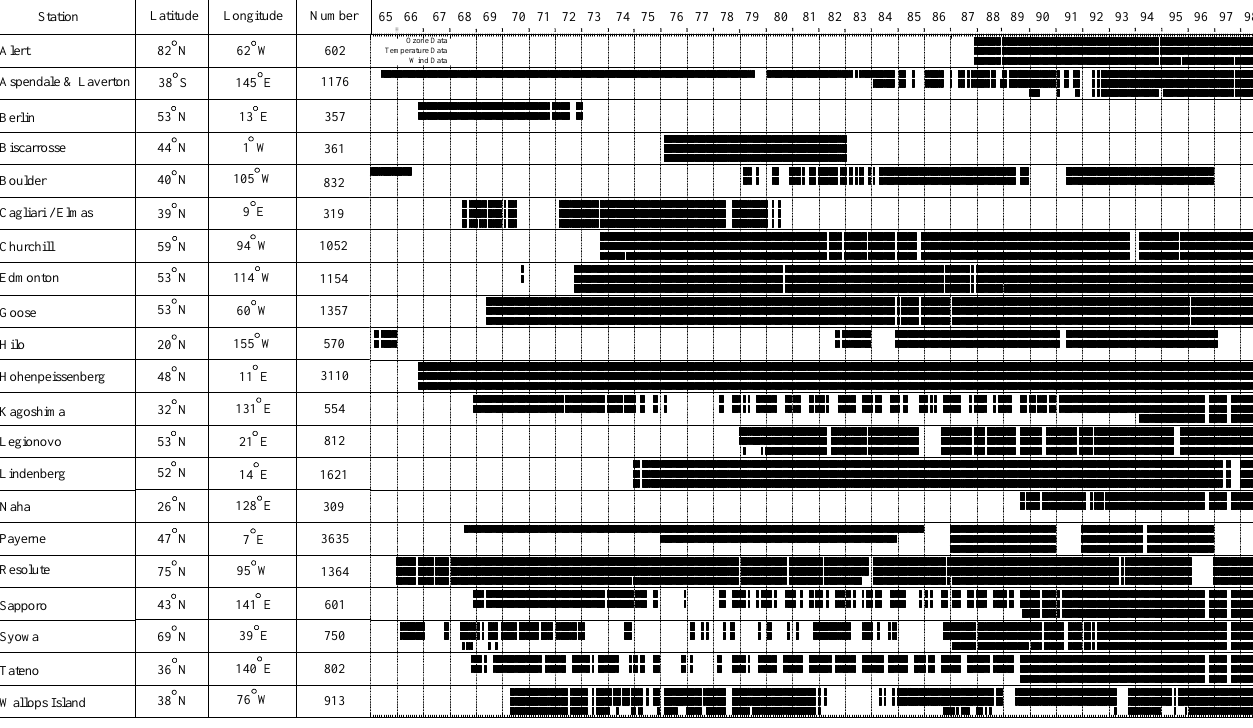
For each of the stations from top to bottom the indicators of available monthly means of ozone, temperature and wind are shown. Symbol denotes that at least one profiles of this parameter for a corresponding month exists.